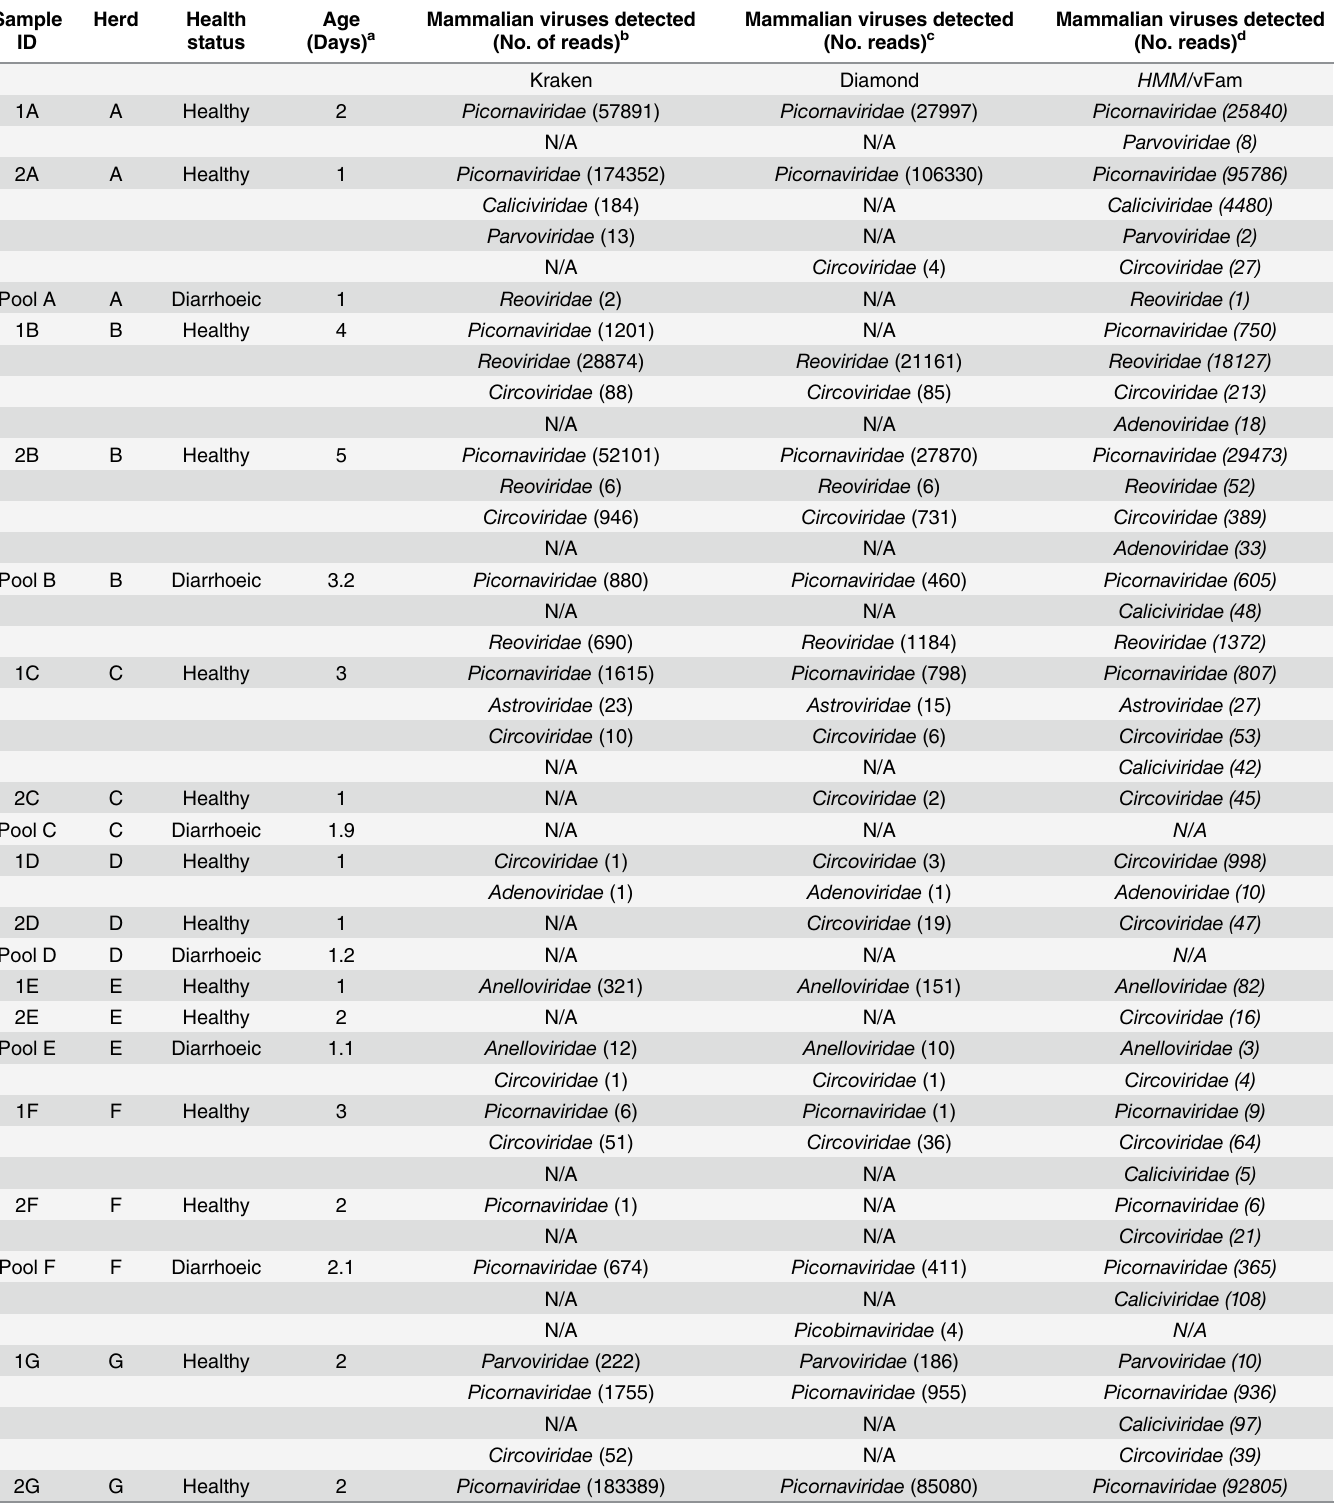
Table 3. Overview of samples and viruses detected at family level in the distal jejunum of neonatal piglets with and without diarrhoea. Sample